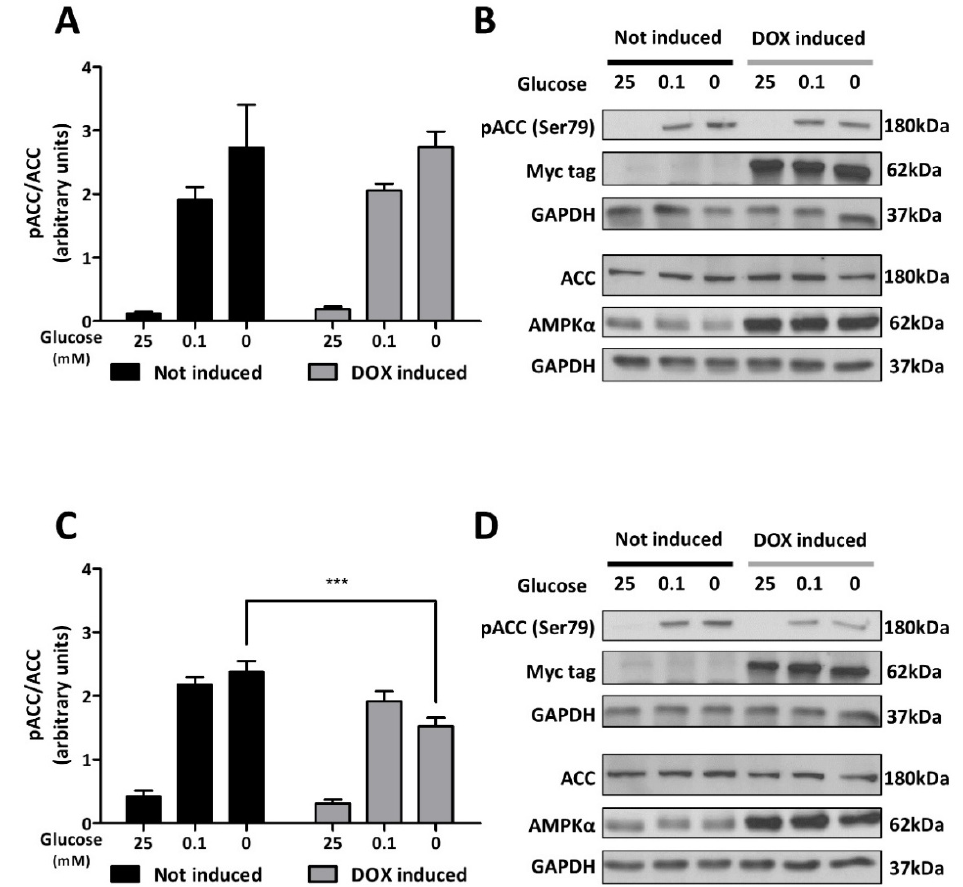
Figure 4. AMPK activity upon glucose deprivation in C6 cells. C6-rtTA-AMPK-DN cells induced or not with DOX (2 µ g/mL, 24 h) were submitted to severe (0.1 mM) or total (0 mM) glucose deprivation for 3 ( A , B ) and 6 h ( C , D ). Phosphorylated ACC and total ACC were immunoblotted in separate gels and their expression level was normalized to GAPDH. ( A – C ) Histograms show means ± SEM. ( B – D ) Blots shown are representative of seven independent experiments. Statistical analyses were performed by two-way ANOVA followed by Bonferroni’s multiple comparison test (*** p < 0.001).